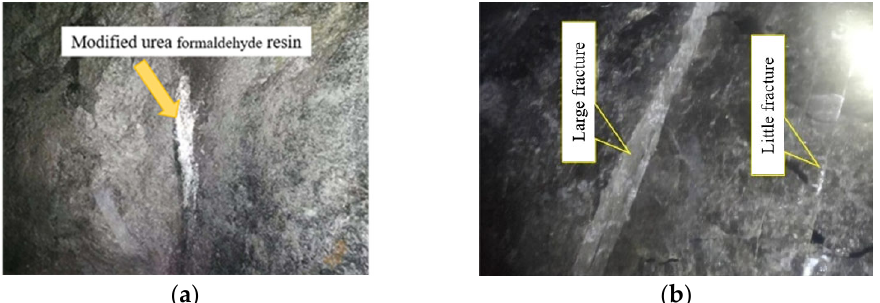
Figure 10. On ‐ site construction cracks revealed. ( a ) On ‐ site fracture picture 1; ( b ) On ‐ site fracture Figure 10. On-site construction cracks revealed. ( a ) On-site fracture picture 1; ( b ) On-site fracture picture 2. picture